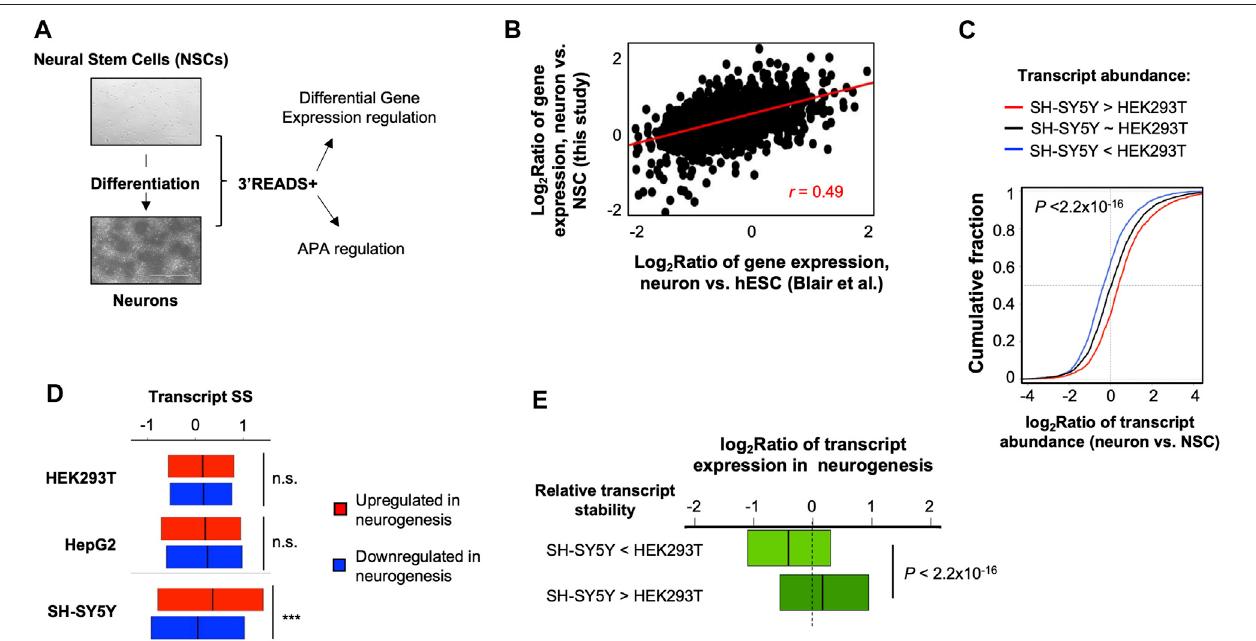
FIGURE2| DistinctmRNAstabilityinSH-SY5Ycellsisrelevanttogeneexpressioninneurogenesis. (A) Aneurogenesismodelusedinthisstudy.Aneuralstemcell (NSC) line (top) was differentiated to neurons (bottom), followed by 3 ′ READS+ analysis by using their total cellular RNAs. The data were used for both gene expression and APA analyses. (B) Scatter plot showing gene expression changes between NSC-derived neurons vs. NSCs and another neurogenesis model, in which neurons were differentiated from human Embryonic Stem Cells (hESCs) (Blair et al.). (C) Cumulative distribution function (CDF) curves of transcript expression changes (log 2 Ratio) in NSC-derived neurons vs. NSCs for three groups of transcripts based on expression difference between SH-SY5Y and HEK293T cells, as indicated. Signi fi cance ofexpression difference oftranscriptswas based on Fisher ’ sexact test by using 3 ′ READS+ data oftotal cellular RNA. The p -value (Wilcoxon test)shown in the plot indicates signi fi cance of difference between transcripts with higher expression in SH-SY5Y cells than in HEK293T cells (red line) and transcripts with higher expression in HEK293T cells than in SH-SY5Y cells (blue line). (D) SS of transcripts in 3 cell lines for genes upregulated or downregulated in neurogenesis. Comparison betweenthetwotranscriptgroupswasbasedonWilcoxontest.n.s.,notsigni fi cant;*** p < 0.001. (E) Boxplotshowinggeneexpressionregulationinneurogenesis(Blair et al.) for two groups of genes with differential stability between SH-SY5Y and HEK293T cells, as indicated. Stability difference between SH-SY5Y and HEK293T was based on data shown in Figure 1C . p -value is based on Wilcoxon